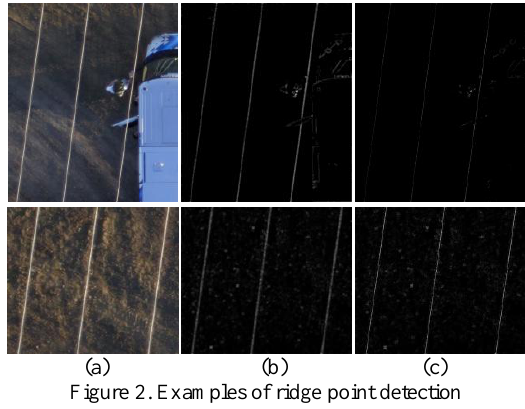
Figure 2. Examples of ridge point